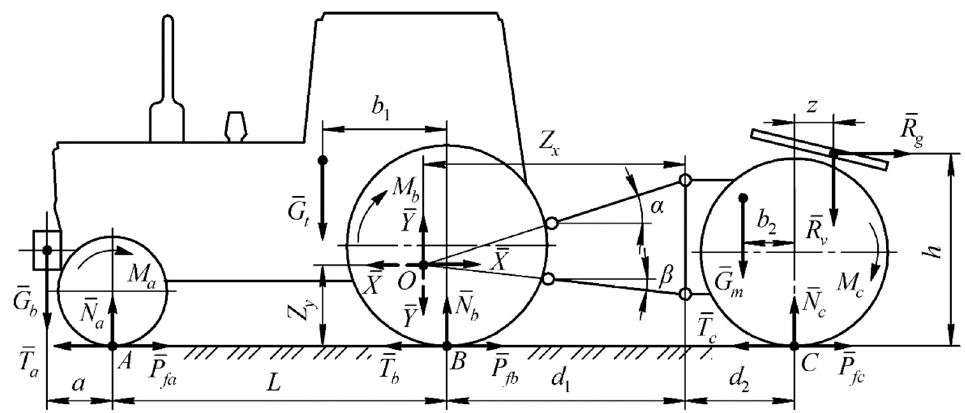
Figure 2. Scheme of forces acting upon the